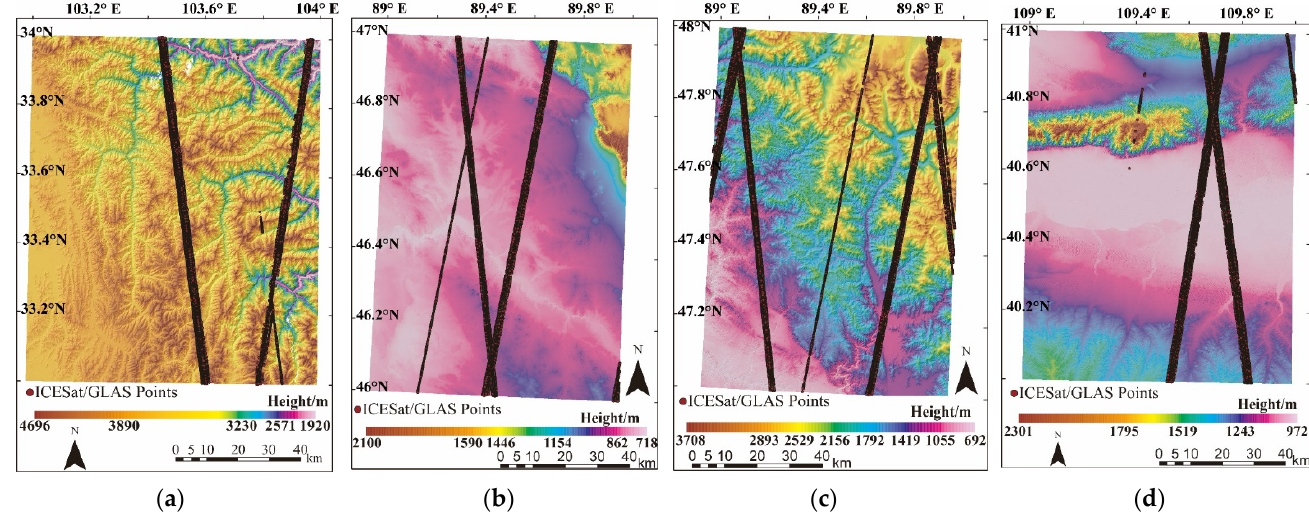
Figure 4. The spatial distribution of elevation in four study areas and the distribution of ICESat/GLAS points: ( a ) Sichuan; ( b ) Xinjiang A; ( c ) Xinjiang B; and ( d ) Inner Mongolia. There are 8804, 13,657, 18,669 and 13,770 reference points in the four study areas before data preprocessing, respectively.